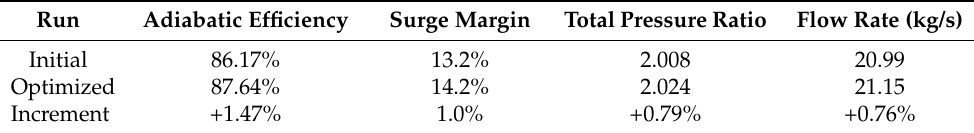
Table 4. The overall performance of optimized and initial